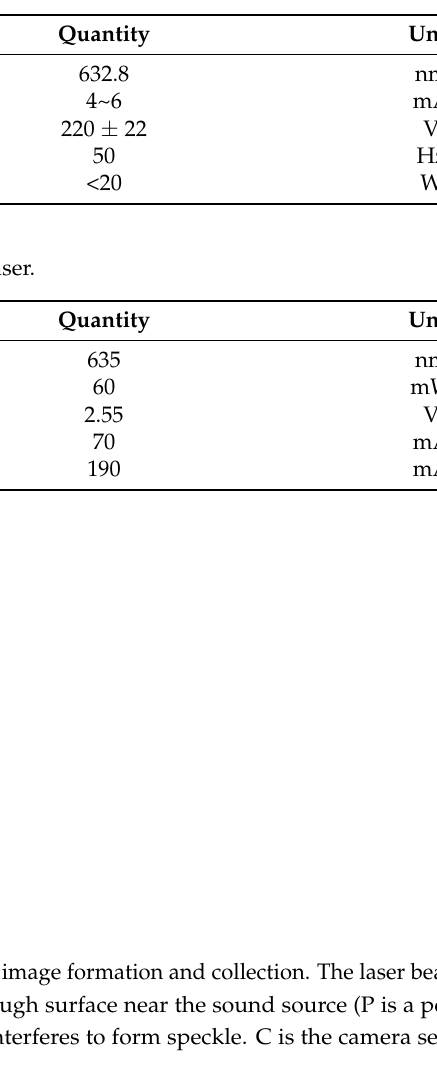
Table 2. Basic parameters of the He-Ne laser.